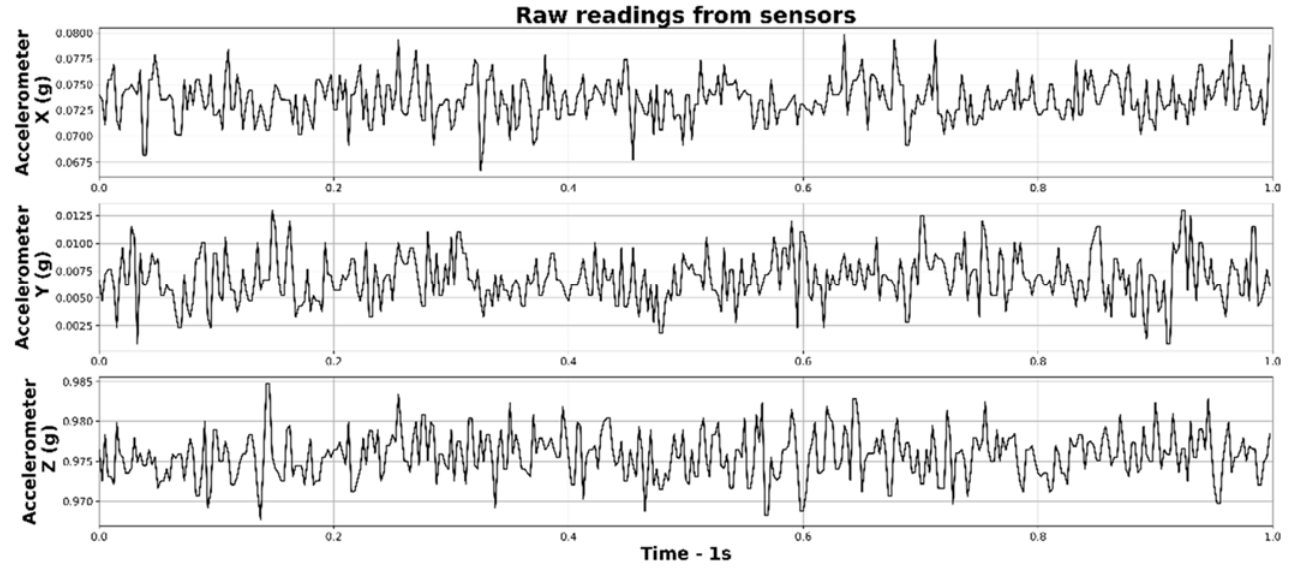
Figure 4. One second of accelerometer readings from the NGIMU unit.